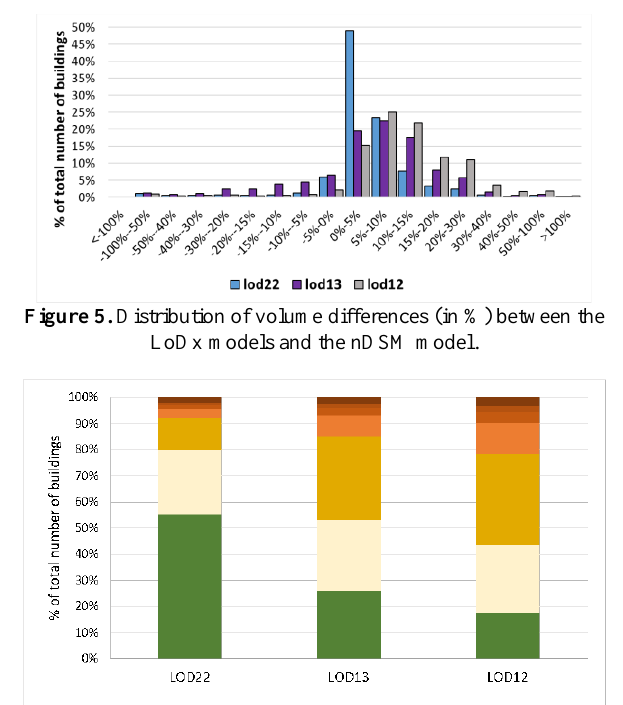
15.6 Table 3. Percentile-based characterisation of the distribution of gross volumes differences (in %) in the LoDx models with respect to the nDSM model. The RMSE is computed on the whole sample and for the 5-95 percentile interval.